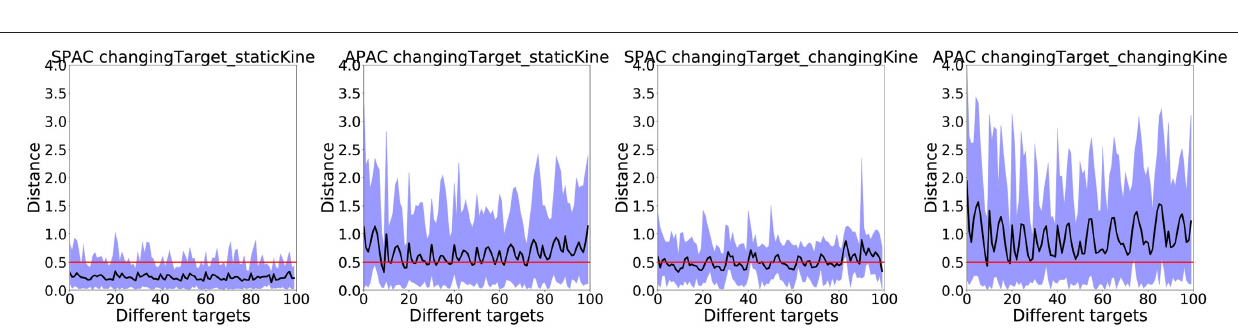
distance of 0.4, which is less than the target zone